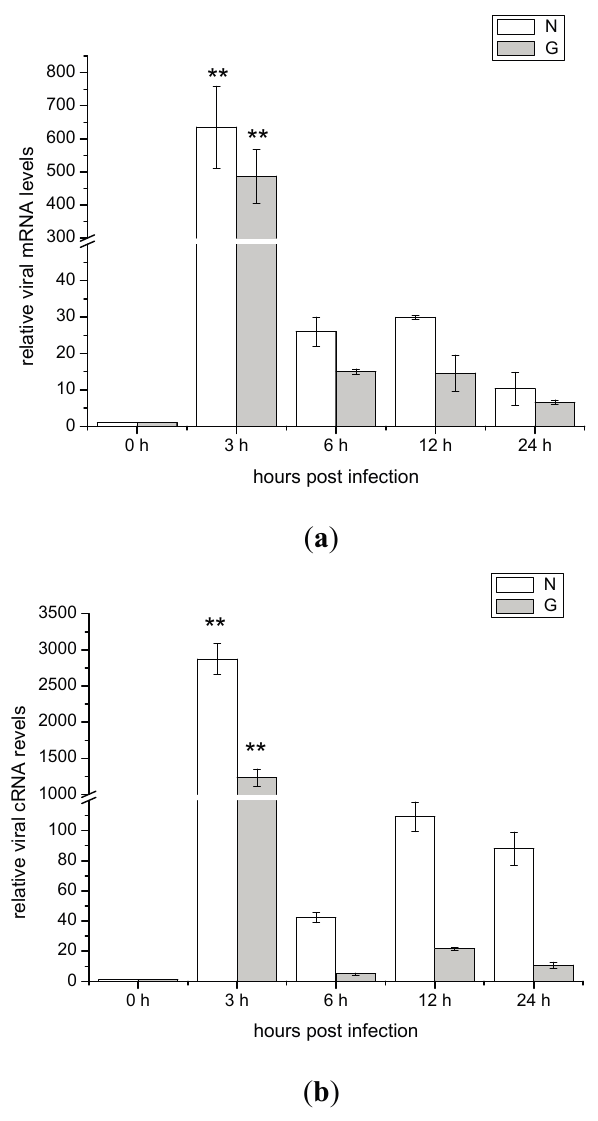
Figure 2. ( a ) Expression of viral N (Nucleoprotein) and G (Glycoprotein) genes mRNA in zebrafish embryonic fibroblast cell line (ZF4) with time after snakehead fish vesiculovirus (SHVV) infection. Expression was determined by qRT-PCR and β -actin was used as an internal control. Data were shown as mean ± SE ( n = 3). The data were submitted to one-way analysis of variance (one-way ANOVA) followed by Fisher’s LSD test using SPSS. The asterisk indicated a statistically significant difference ( ** p < 0.01) compared with 0 h (set as 1); and ( b ) Expression of viral N and G genes cRNA in ZF4 with time after SHVV infection. Expression was determined by qRT-PCR and β -actin was used as an internal control. Data were shown as mean ± SE ( n = 3). The data were submitted to one-way analysis of variance (one-way ANOVA) followed by Fisher’s LSD test using SPSS. The asterisk indicated a statistically significant difference ( ** p < 0.01) compared with 0 h (set as